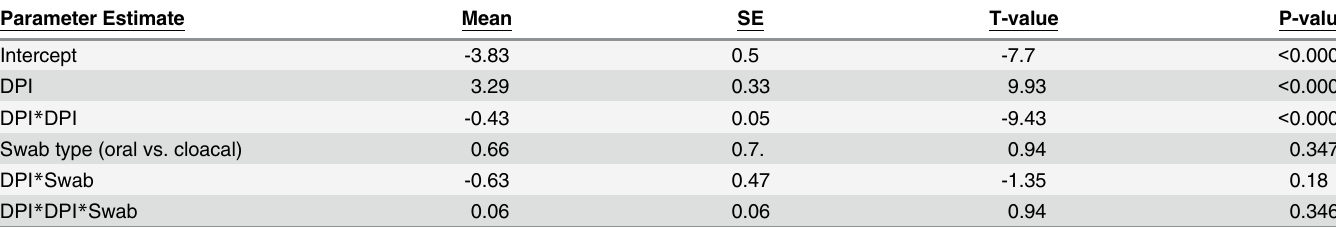
Table 8. Parameter estimates of the best model as selected by AIC for virus shedding in experimentally challenged common eiders.